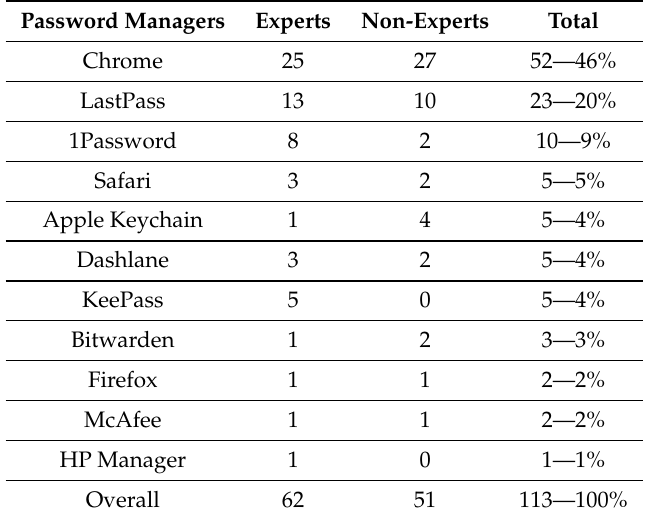
Table 22. Types of password managers used by 113 users (62 Experts and 51